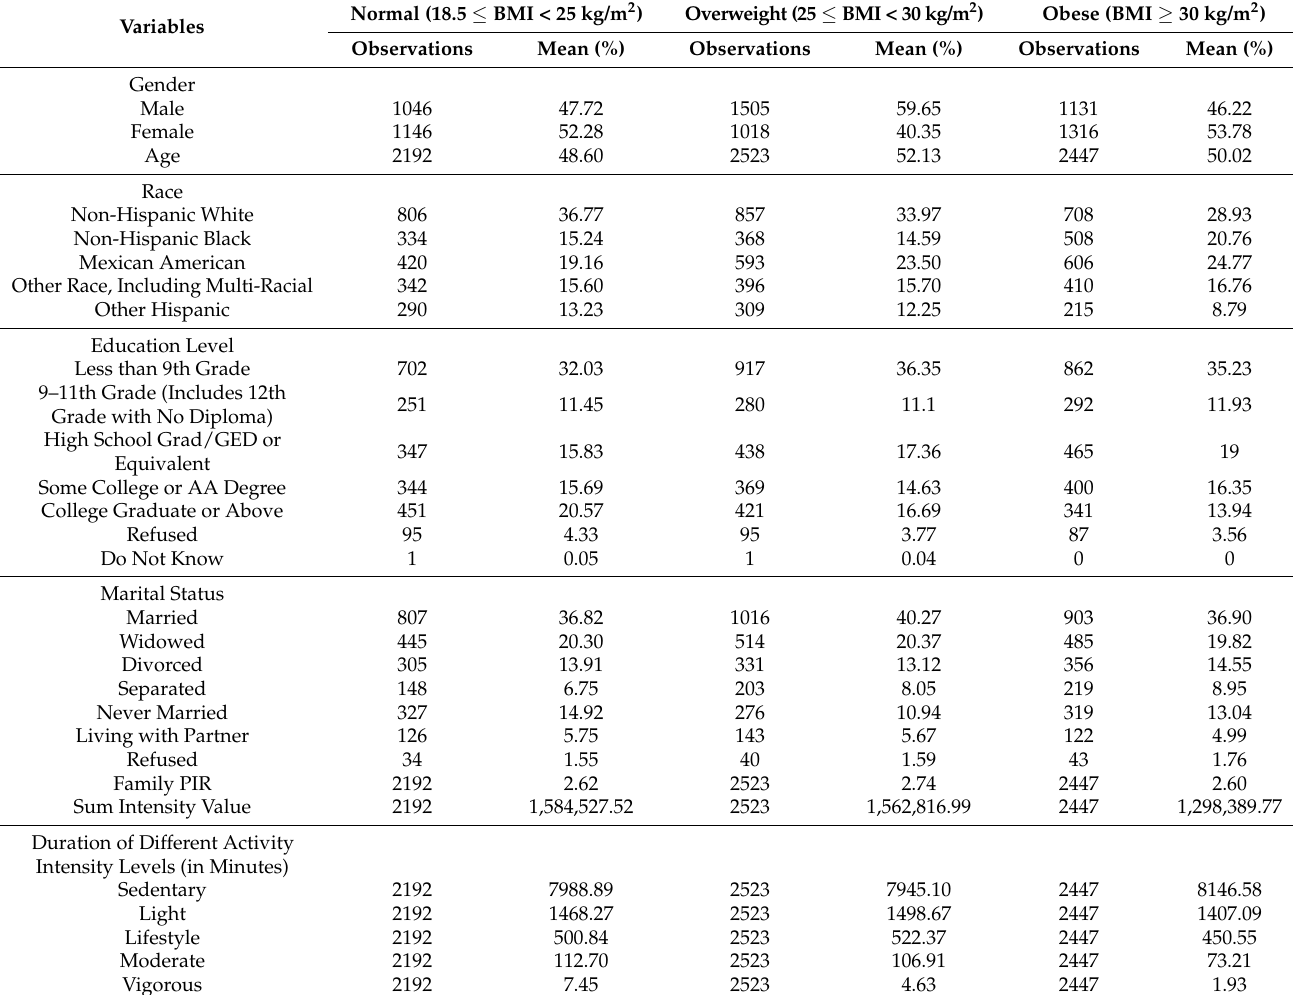
Table 1. Study population